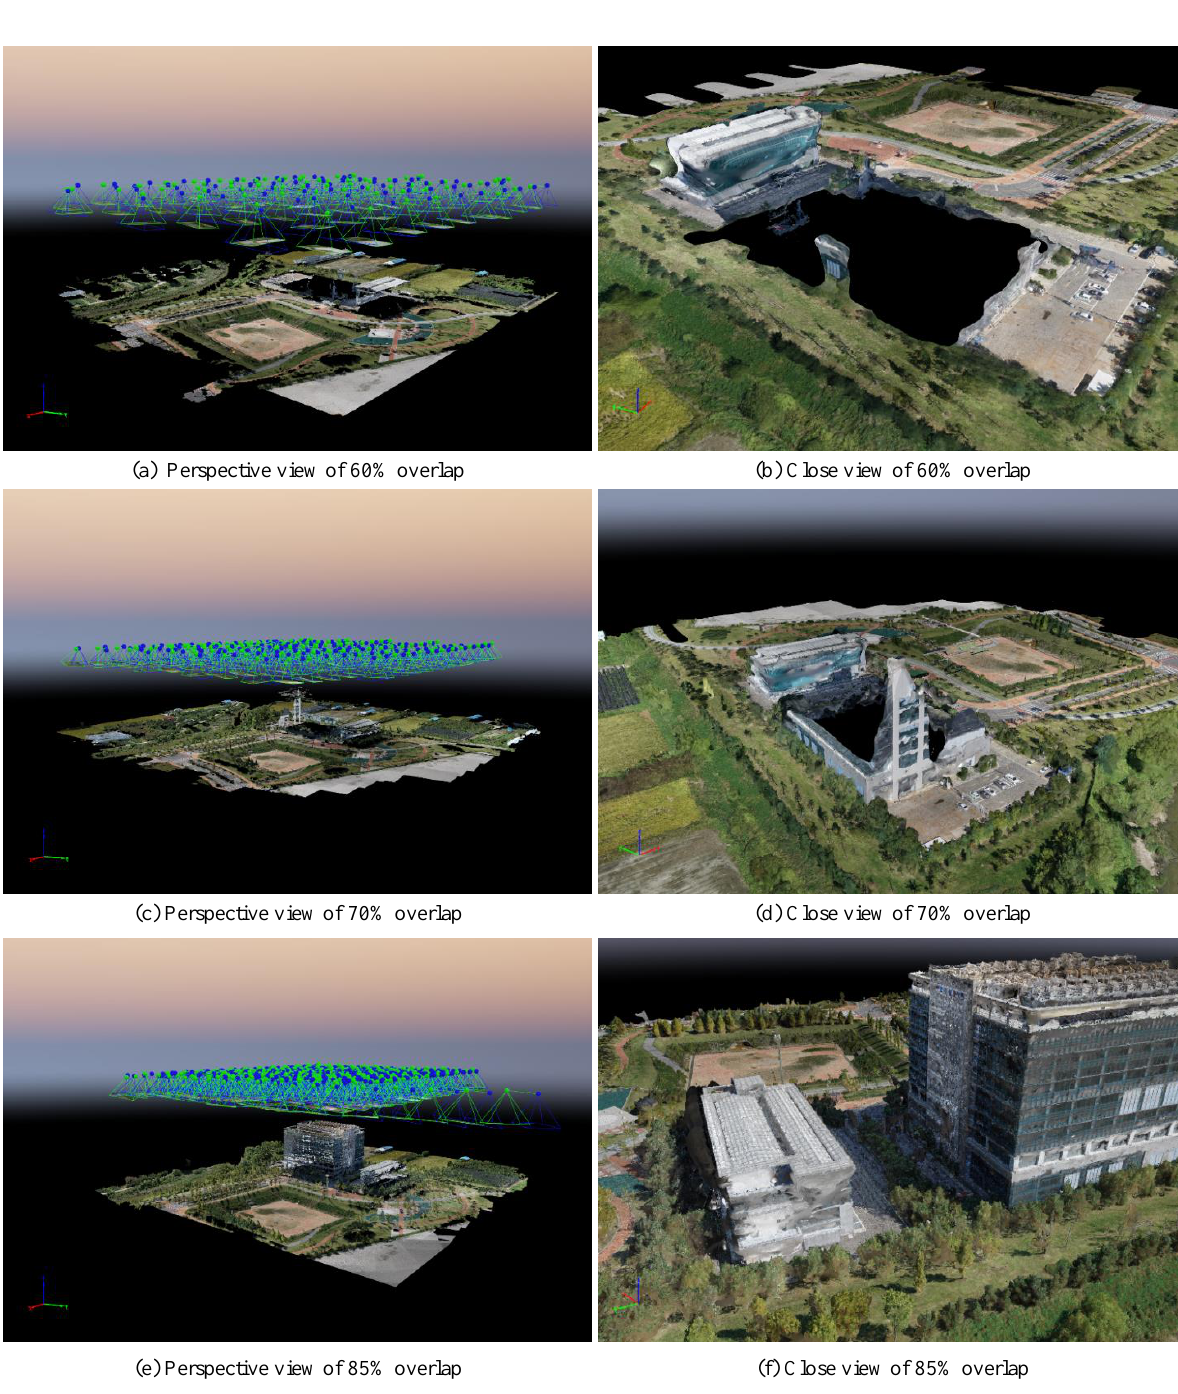
Figure 2 Photographing points and point